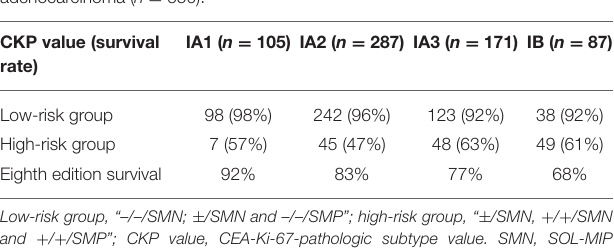
TABLE 4 | Five-year survival rate comparing the eighth edition stage and CEA-Ki-67-pathologic subtype (CKP) value in patients with stage I pulmonary adenocarcinoma ( n =